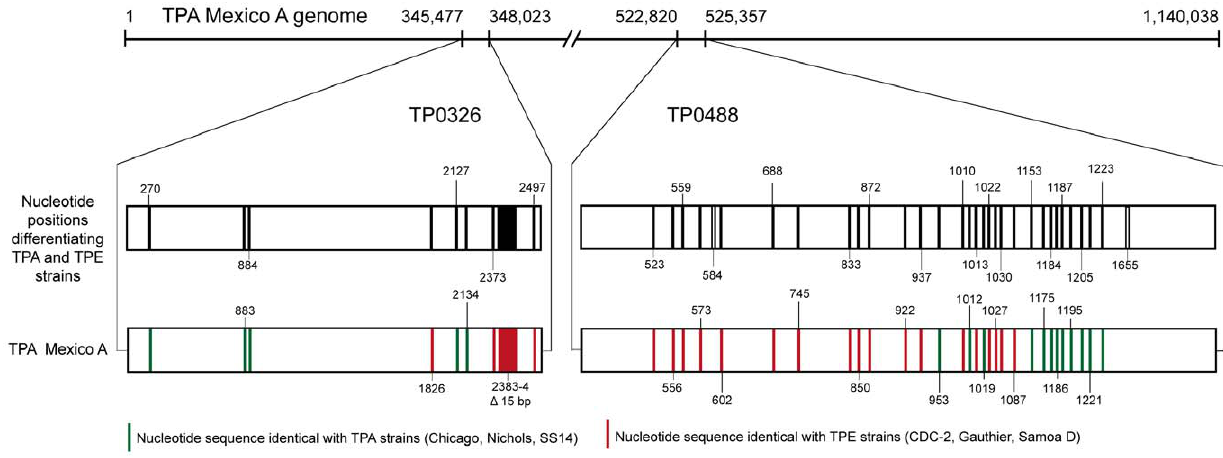
PLOS Neglected Tropical Diseases |